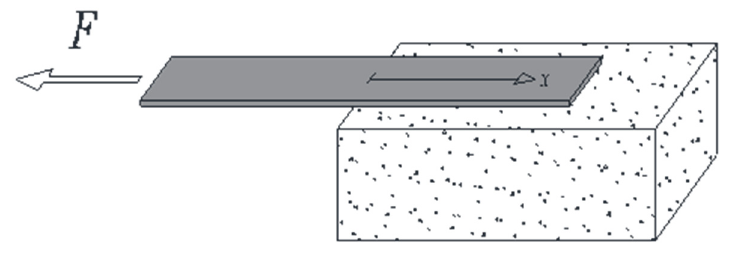
Figure 5. Bond test setup.